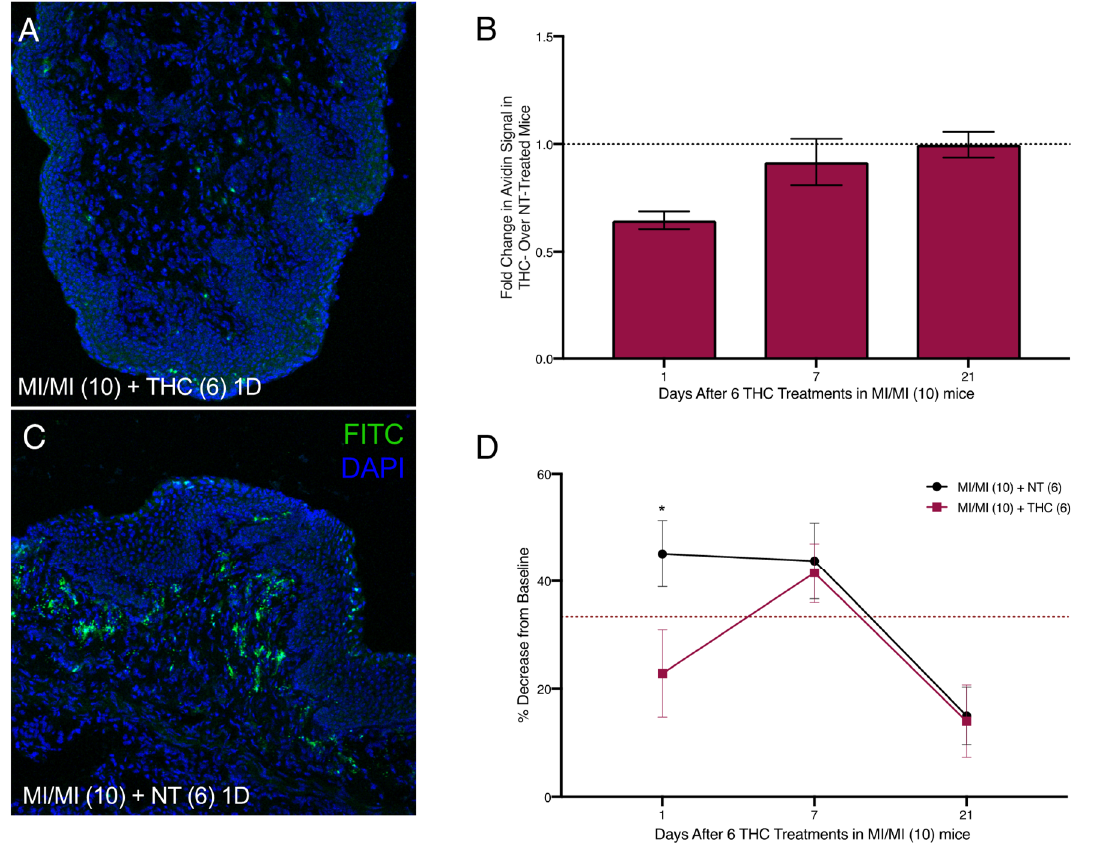
Figure 5. Reduced vaginal mast cell density and ano-genital sensitivity following six intra-vaginal therapeutic THC treatments after 10 vaginal MI challenges in previously sensitized ND4 female mice. ( A , C ) Representative confocal images of vaginal canal tissue from mice that were sensitized and challenged with MI and subsequently treated with THC ( A ) or untreated, that is, NT ( C ), at one day after the last treatment, respectively. Mast cells stained with FITC-conjugated avidin (green) and nuclei counterstained with DAPI (blue); 200 × magnification. ( B ) Mast cell density displayed as fold change in avidin signal in THC-treated over NT mice at 1, 7, and 10 days after the 6th THC treatment; 6–7 mice / treatment group. Black dotted line denotes no change in MC abundance. ( D ) Anogenital tactile sensitivity of MI challenged mice treated with NT (black) or therapeutic THC (red) 1, 7, and 10 days after the 6th THC treatment; n = 8–9 mice / treatment group. Results displayed as mean ± SEM. Significance with respect to control group * p < 0.05.